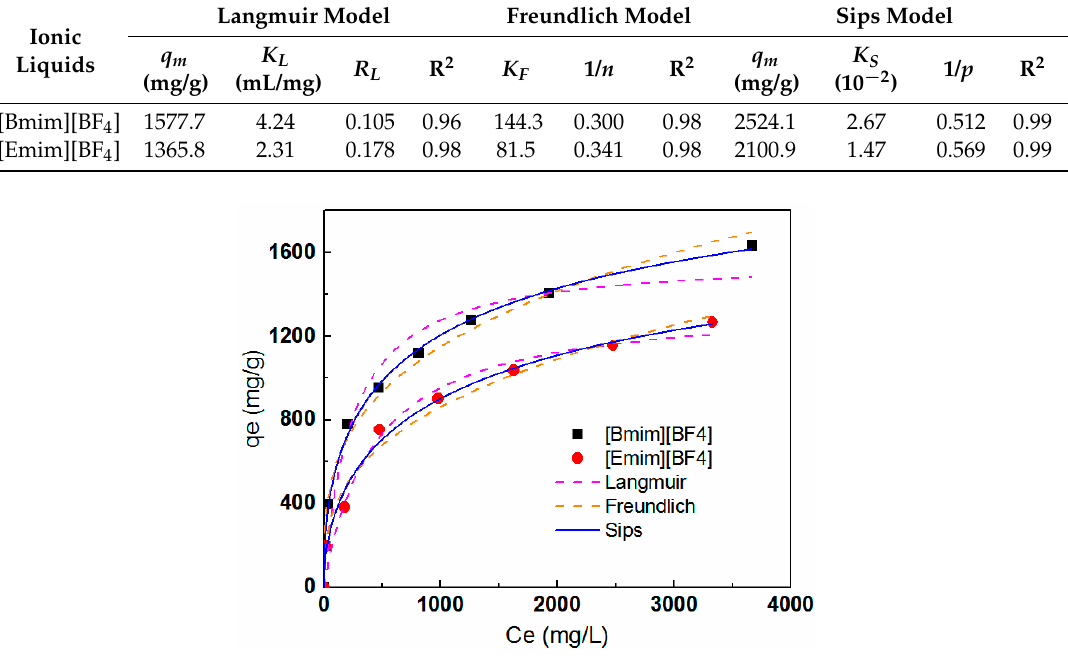
Figure 5. Langmuir, Freundlich, and Sips isotherms for adsorption of ionic liquids ([Bmim][BF 4 ] and [Emim][BF 4 ]) onto ion-exchange resin (Amberlite IR 120Na).